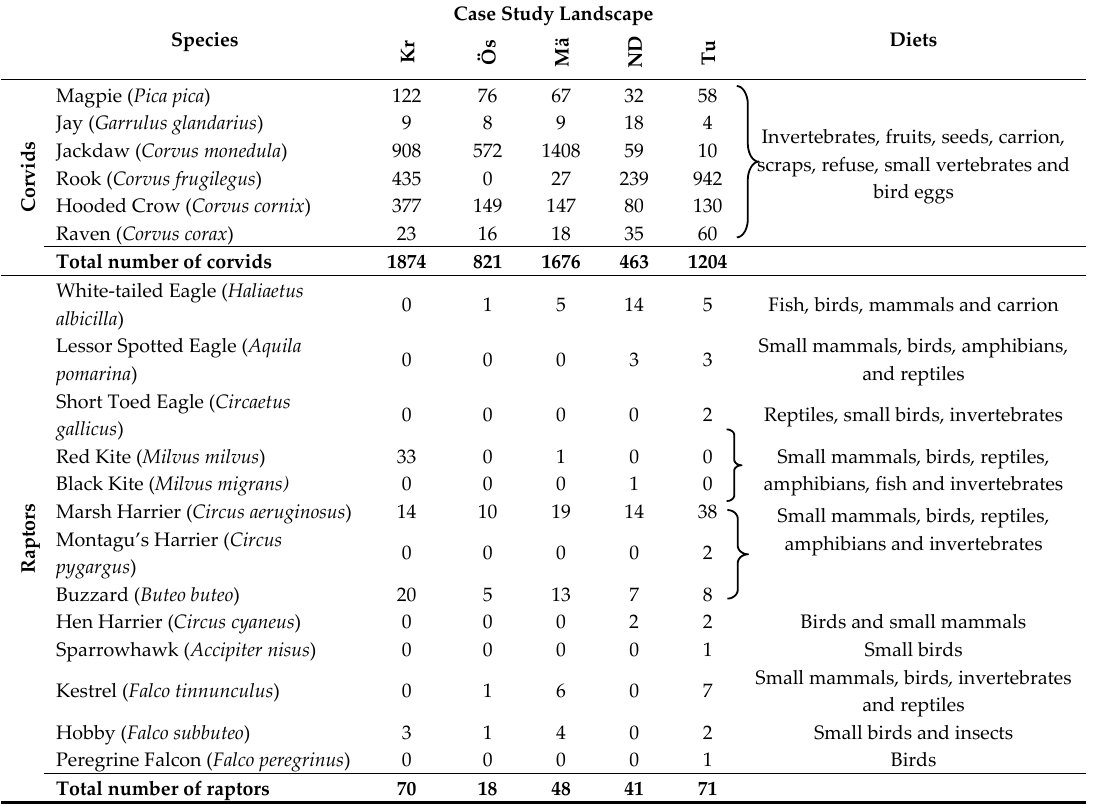
Table 2. Number of observed omnivorous corvid birds and carnivorous raptors observed during this study, and their dietary requirements [82,83].